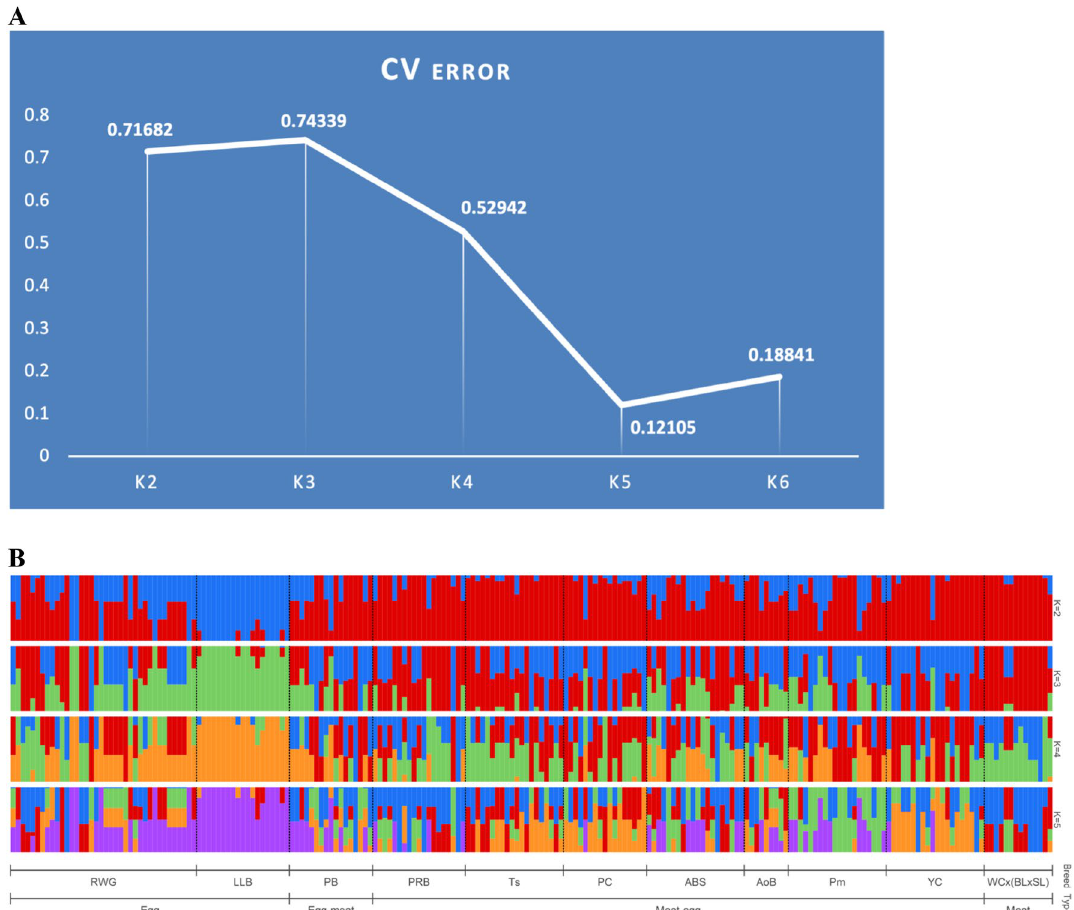
Figure 4. Population structure based on the genetic variation in the 11 core breeds genotyped for five SNP markers at the NCAPG - LCORL locus. ( A ) Elbow method-based analysis of cross-validation (CV) error values depending on number of ancestral populations (K). ( B ) Admixture bar plots generated by Bayesian clustering using the ADMIXTURE program. Each admixture plot represents a cluster structure of the studied breeds/ breed types depending on number of ancestral populations (K), with the latter being optimal at K = 5. Core breeds: RWG Russian White, LLB Leghorn Light Brown, PB Pantsirevka Black, PRB Plymouth Rock